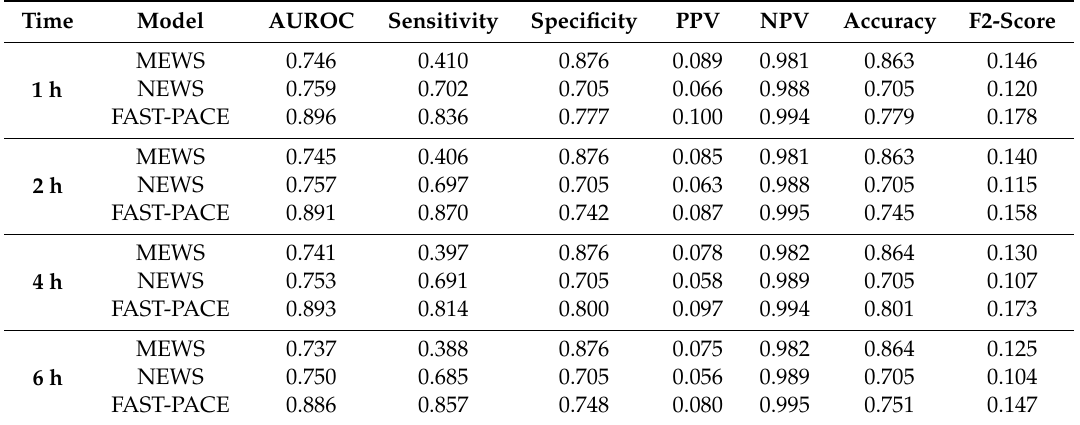
Table 5. Cardiac arrest prediction